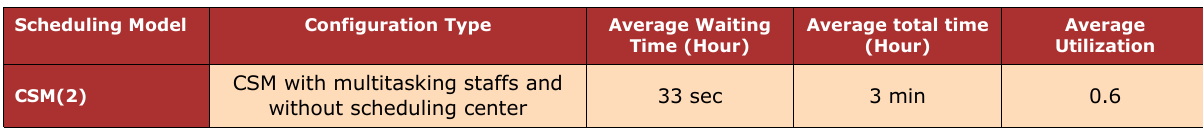
Table 17. Properties of final configuration for settings with high interaction level.